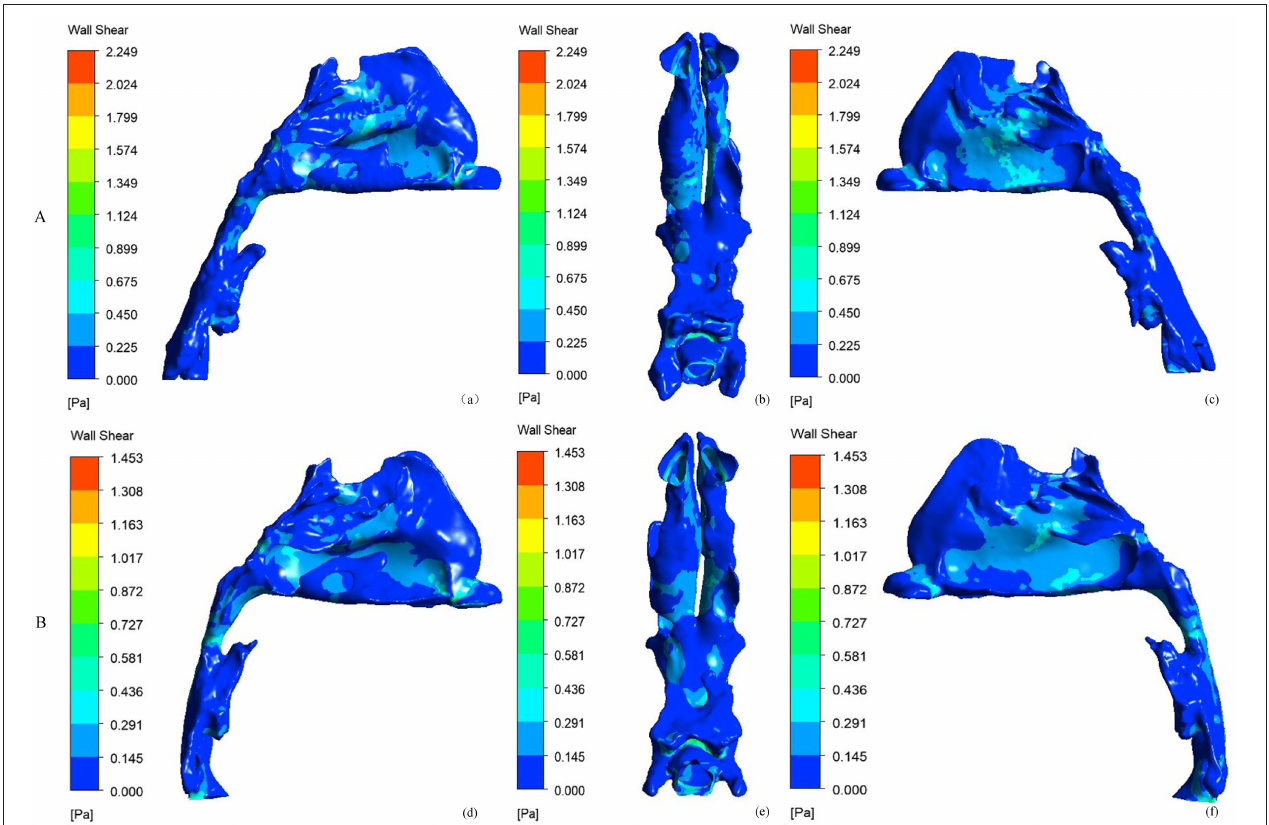
FIGURE 4 | Side and bottom views of the wall shear stress (Pa) of nasal cavity. (A) before RME, (B) after RME.